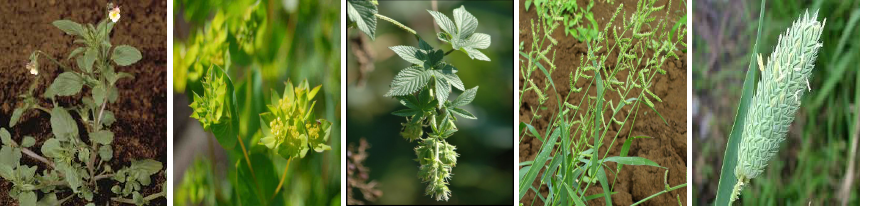
Figure 3. From left to right: Field pansy, Hare’s ear mustard, Japanese hop, Jungle rice, Little seed (Source: [41]).